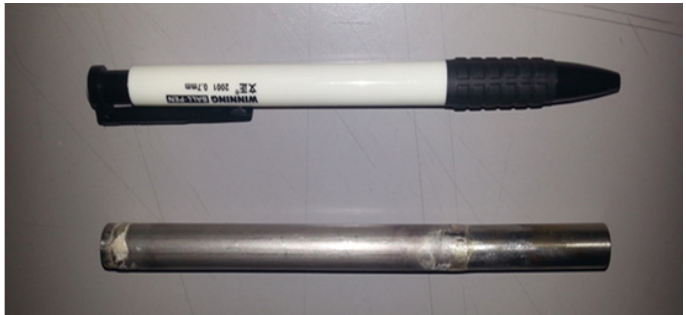
Figure 3. The dense Pd-Ag membrane.